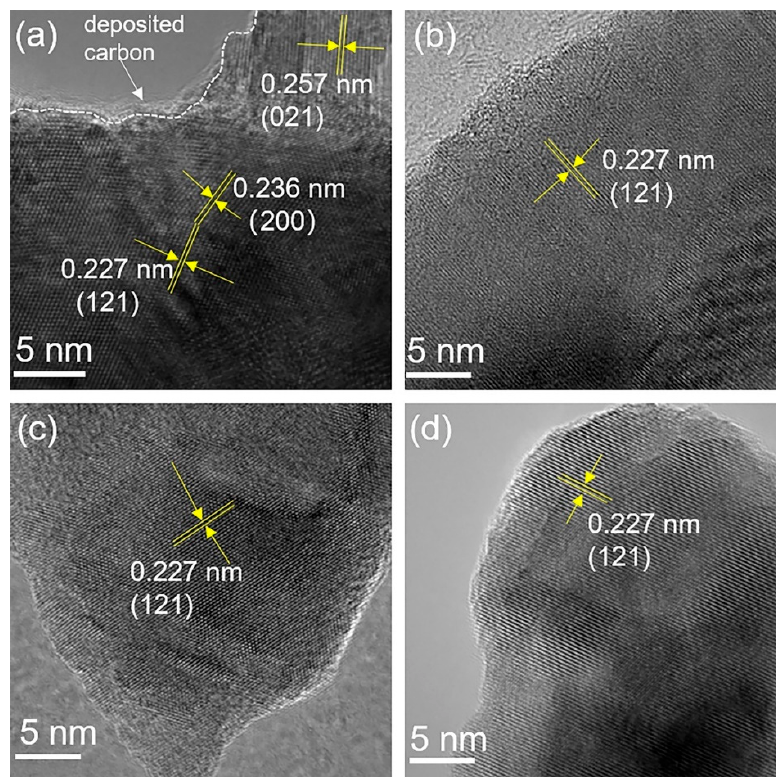
Figure 2. HRTEM images of ( a ) MC, ( b ) MC-Ni-1, ( c ) MC-Ni-1.5 and ( d )